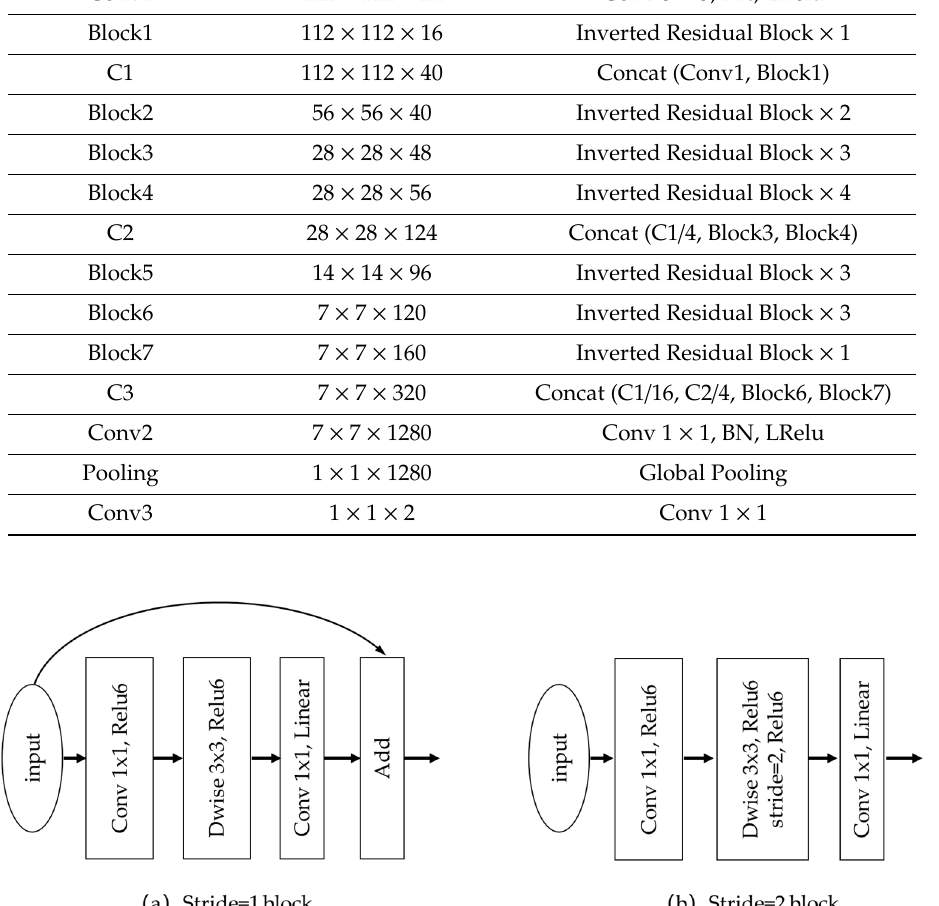
Table 1. Mobilenet-v2-Dense configuration. (“Conv” and “Concat” denote convolution and concatenation, respectively).